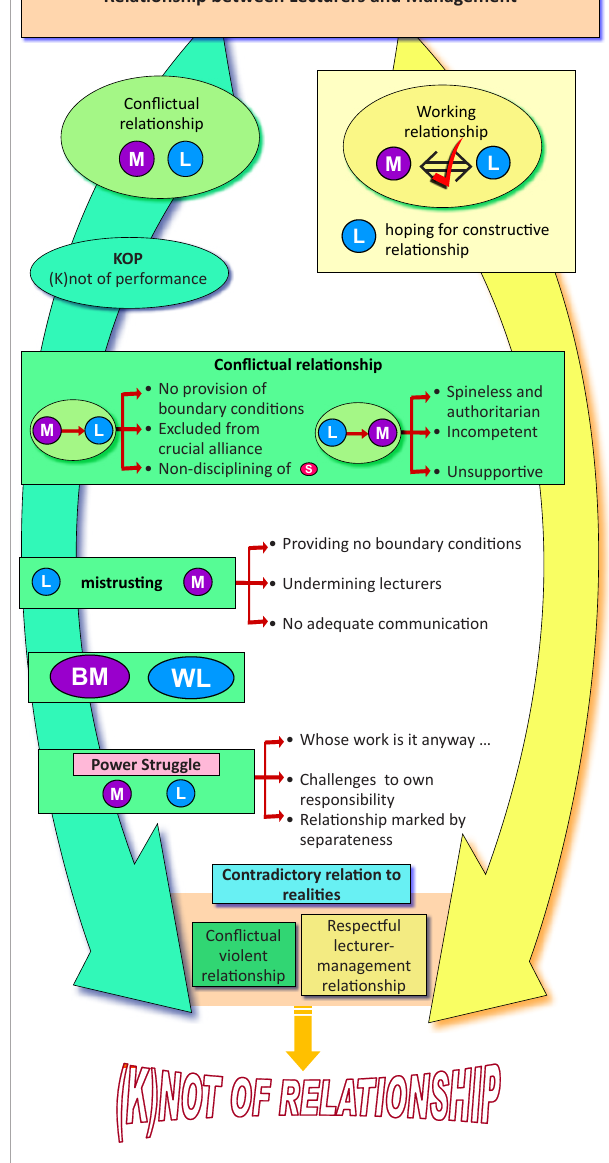
FIGURE 1: Interconnections between themes, operating in the relationship between lecturers and management of historically Black